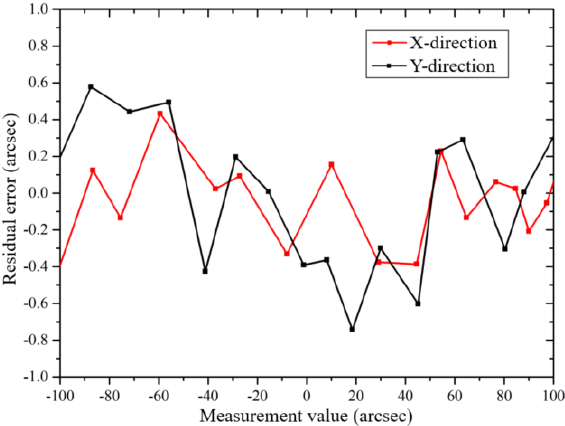
Figure 5. Calibration of the laser autocollimator.